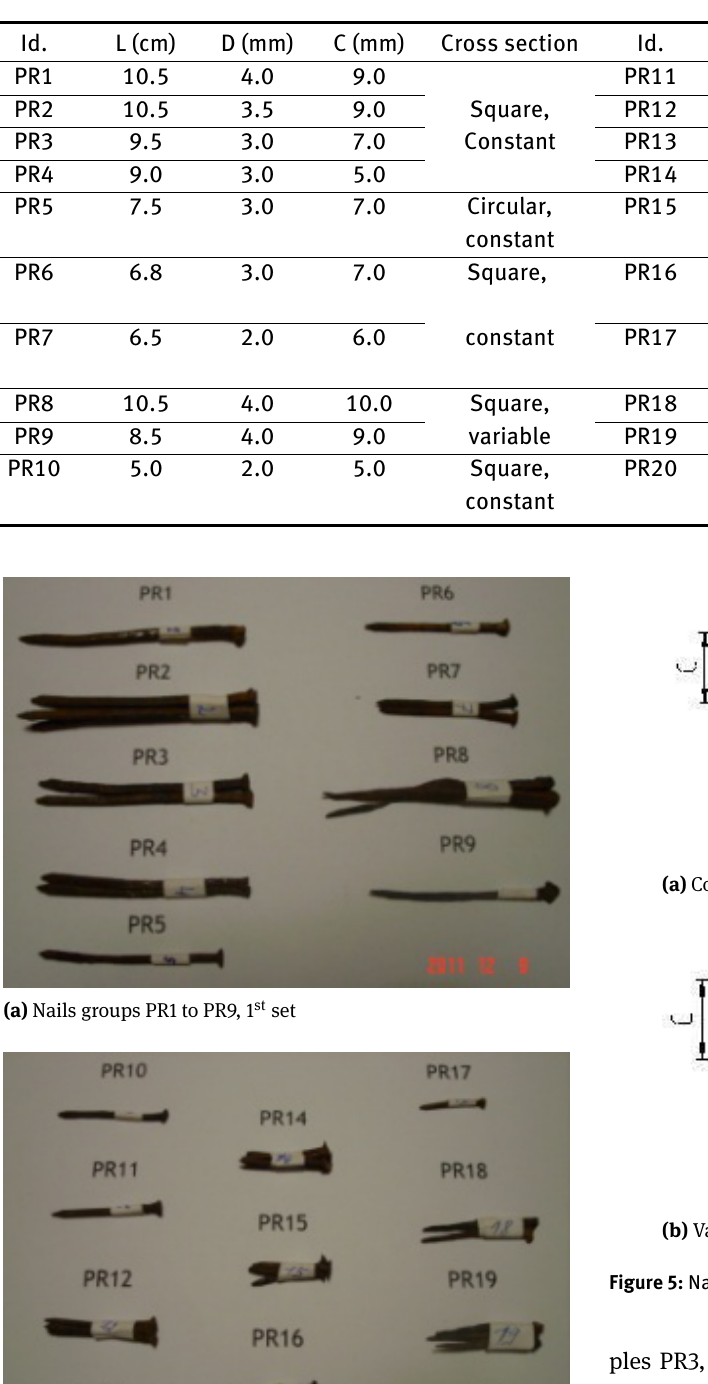
Table 1: Geometrical and dimensional characterization of nails.